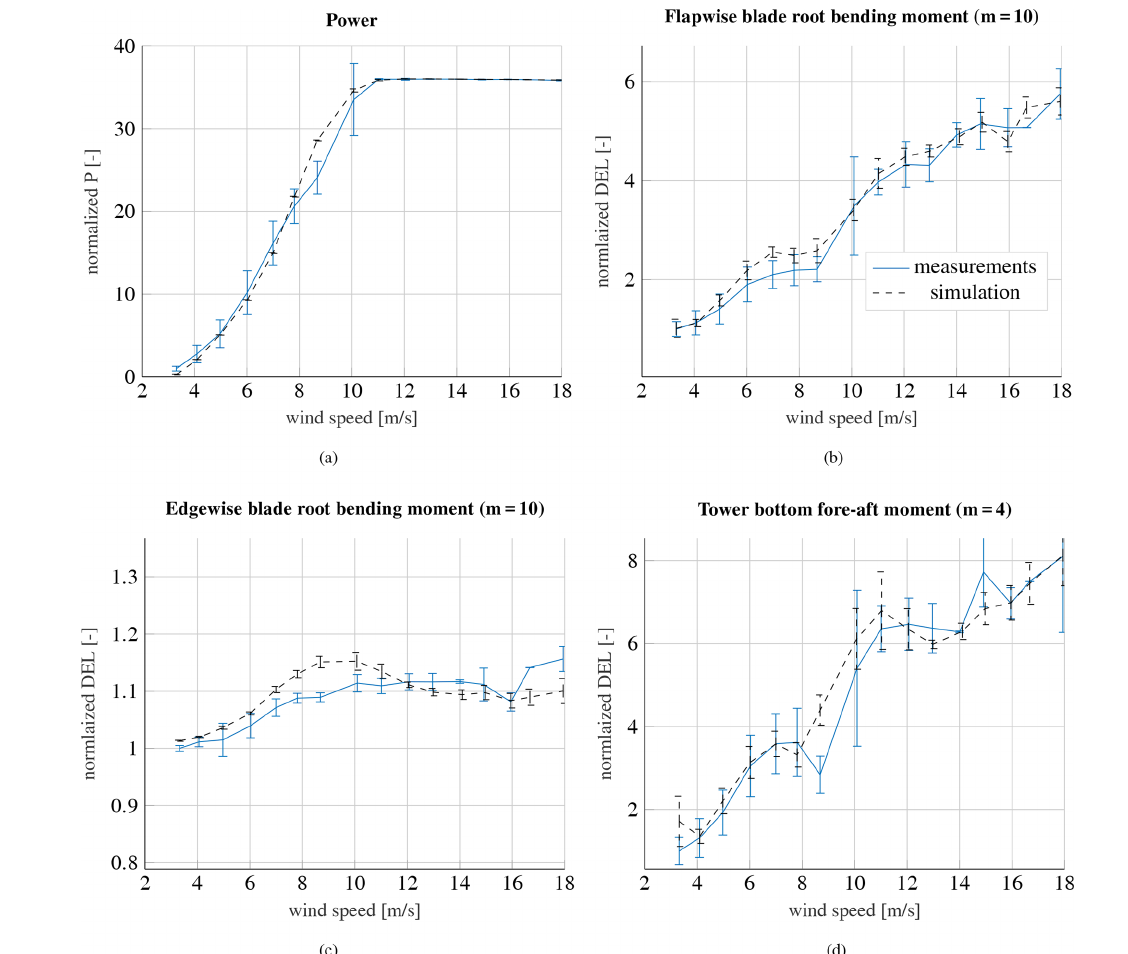
Figure 7. Measured and simulated power (a) , flapwise blade root moment (b) , edgewise blade root moment (c) and tower bottom fore-aft moment (d) at WTG 2 at an ambient turbulence intensity of 12% and wake-free inflow.